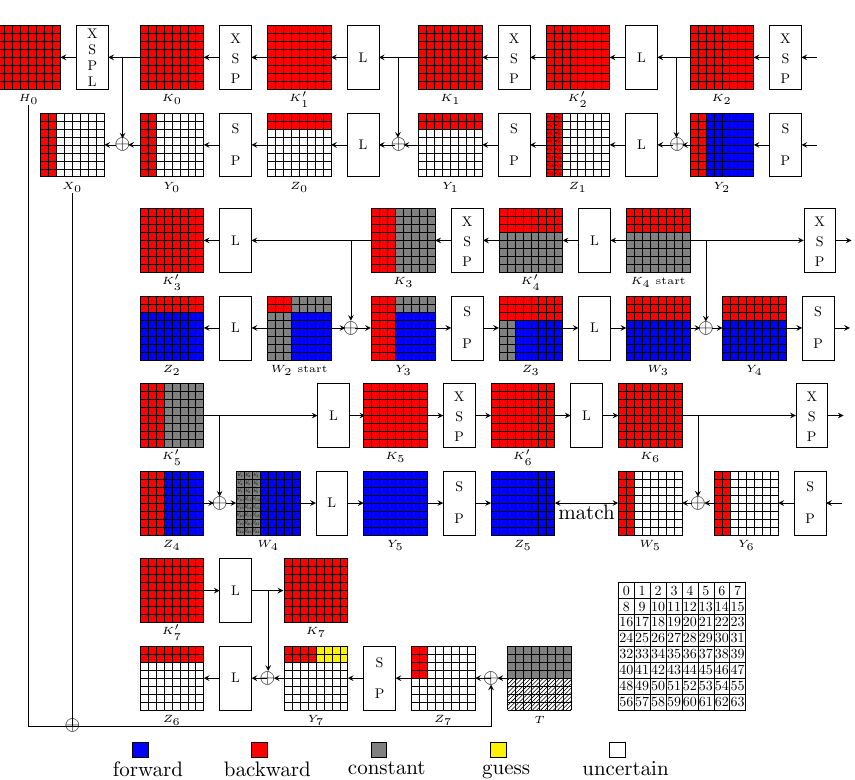
Figure 6: 7.5-round preimage attack on Streebog-256 compression